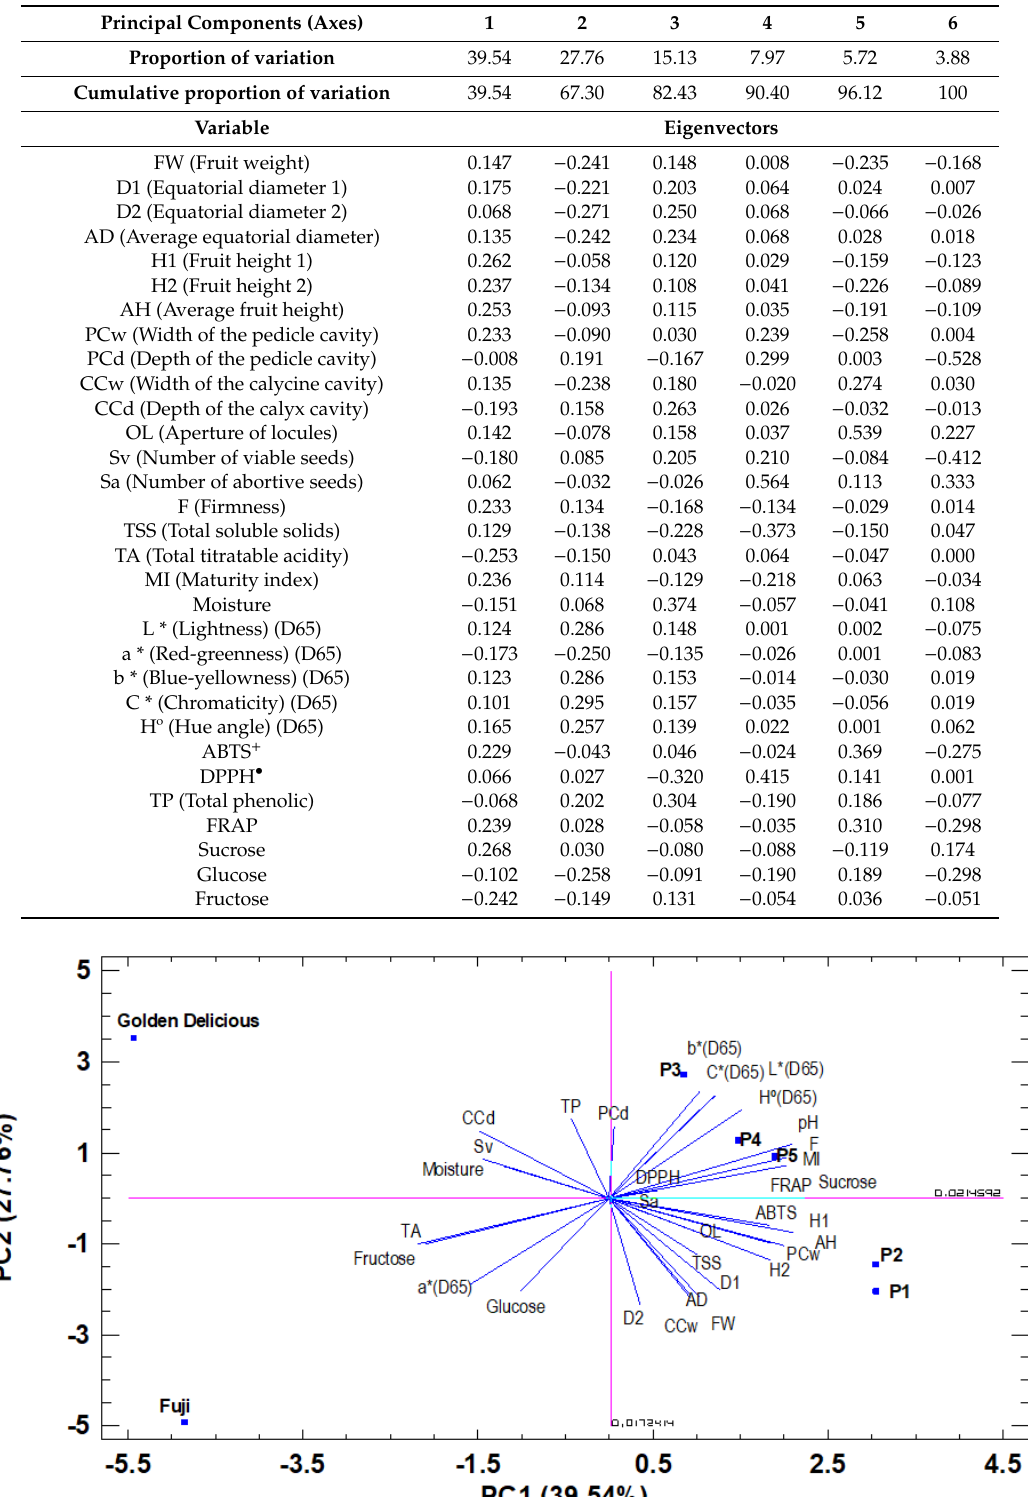
Table 7. Eigenvalues, proportion of variation and eigenvectors associated with principal components of the principal component analysis (PCA).